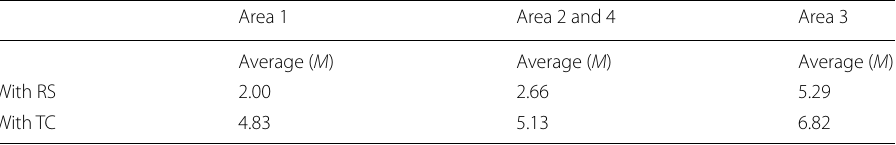
Table 9 Average performance for the Monarch image in terms of modulation order